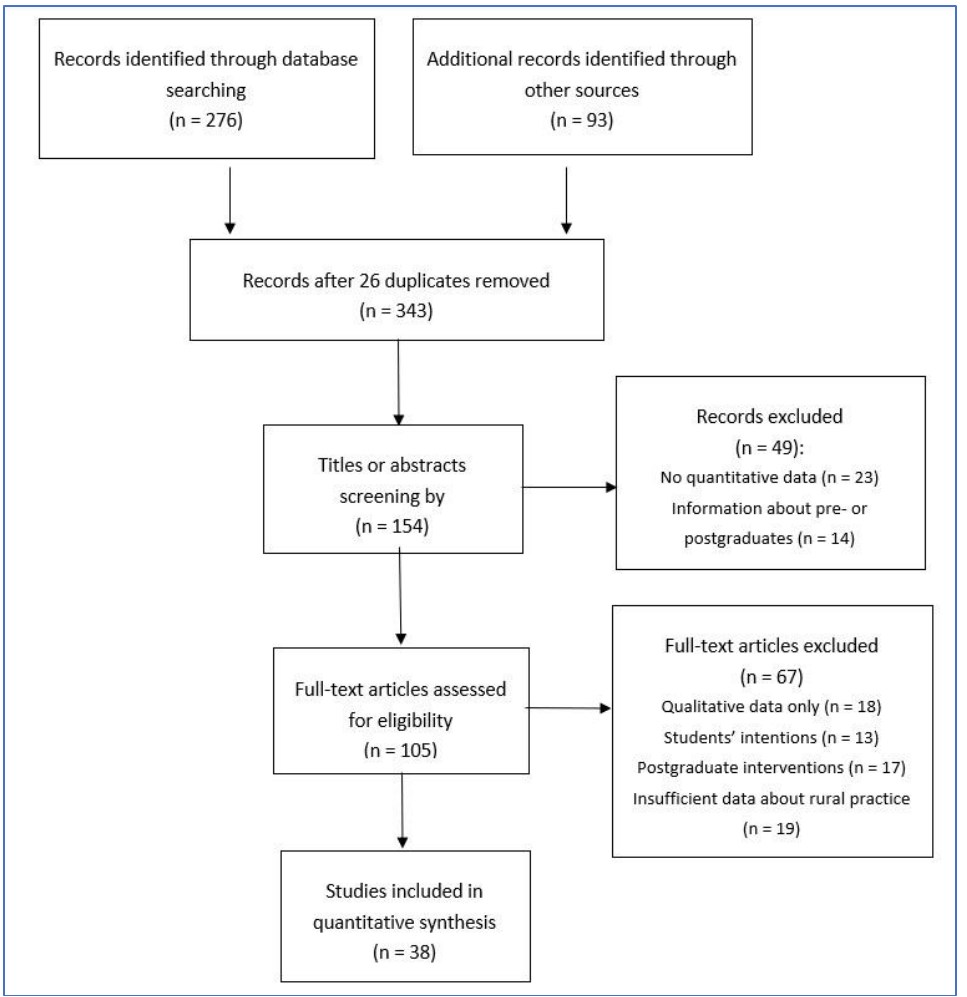
Figure 1. Flow diagram of study selection.